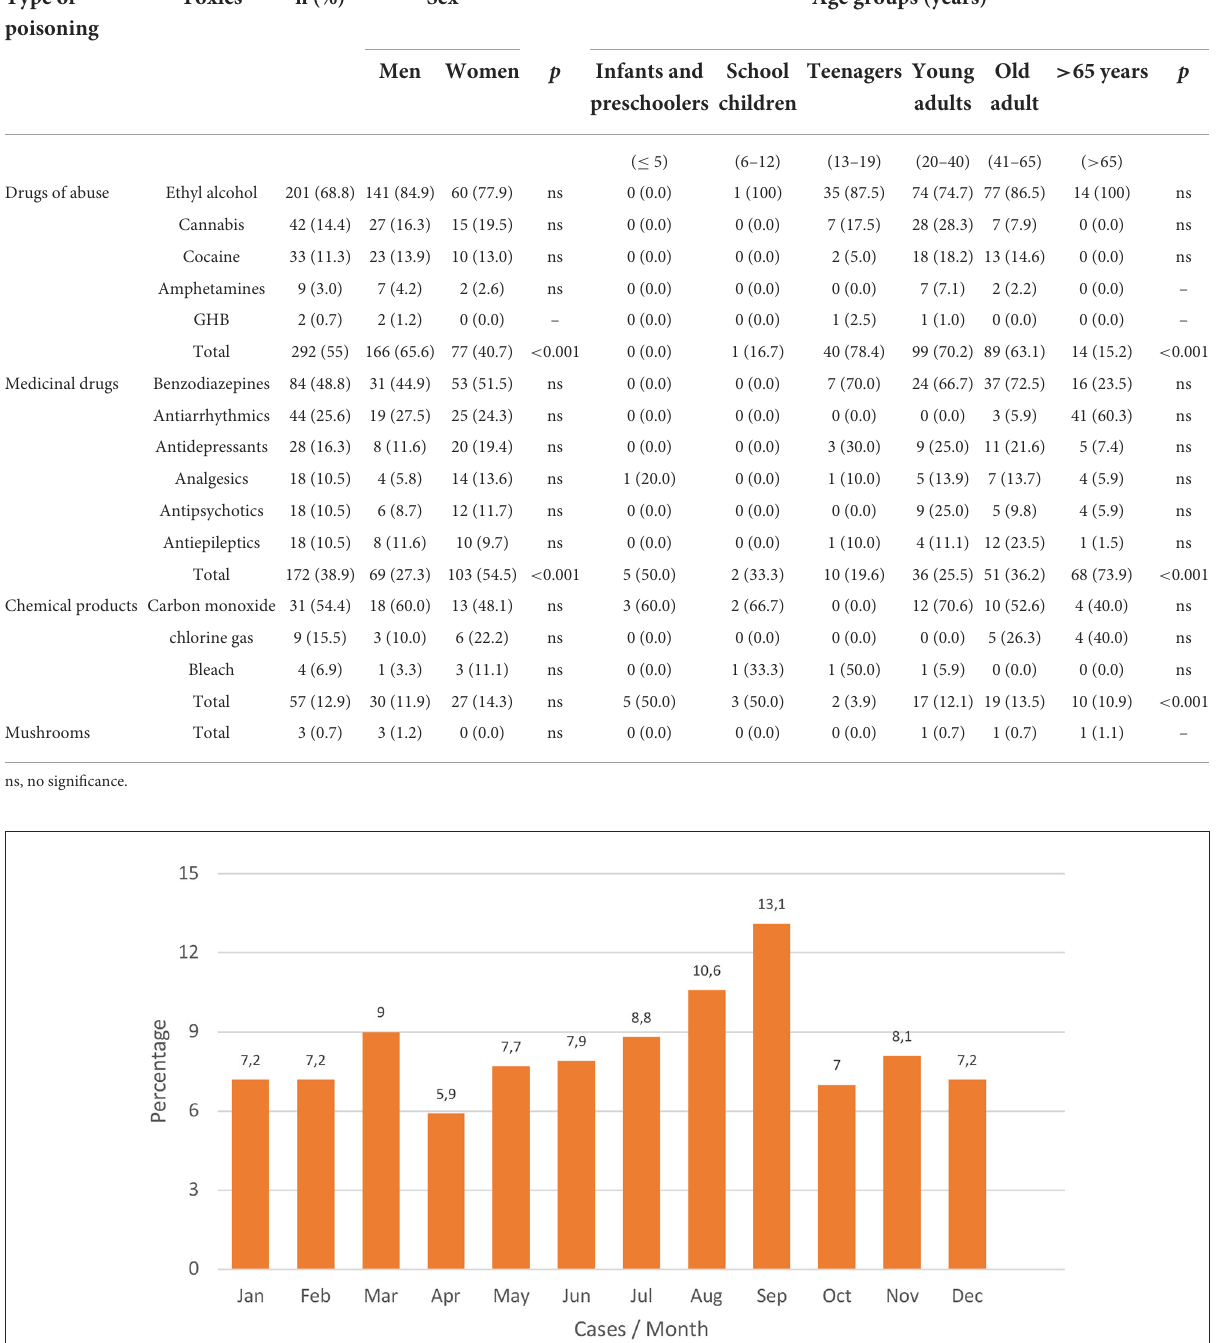
more than half of the cases (58.6%) before 4h. The mortality rate in the emergency department was 0% for all types of acute